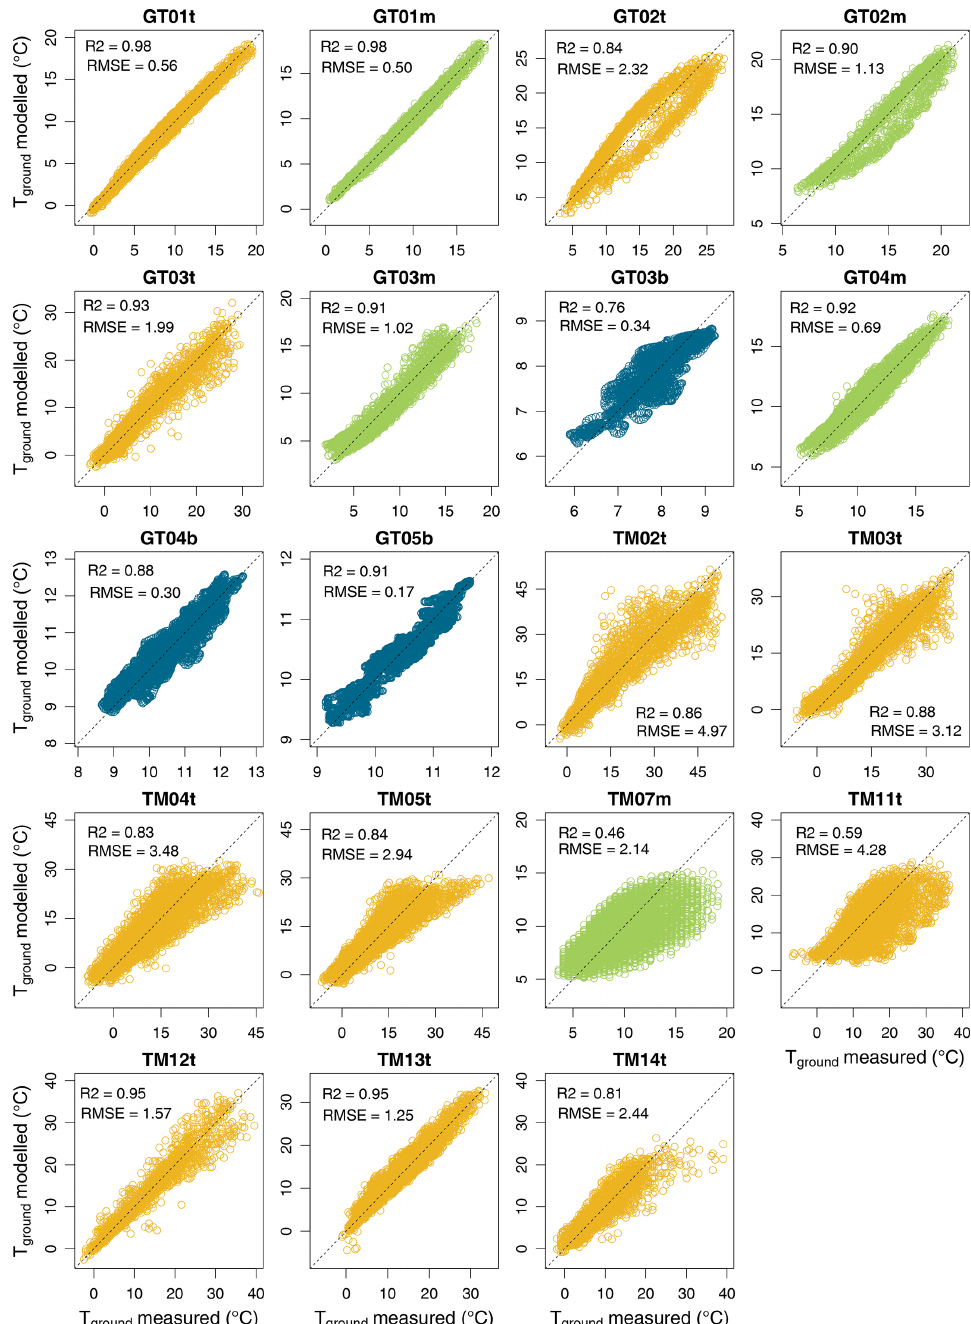
Figure B1. Scatter plots of measured vs. modelled ground temperature for each time series that was gap-filled using a linear regression model and data from a logger in the vicinity. Colour code according to Fig. 3. The data period and regression equations considered for the validation procedure of each time series are provided in the supplementary file “information_sheet_data_gap-filling.ods” (see Sect. 6).